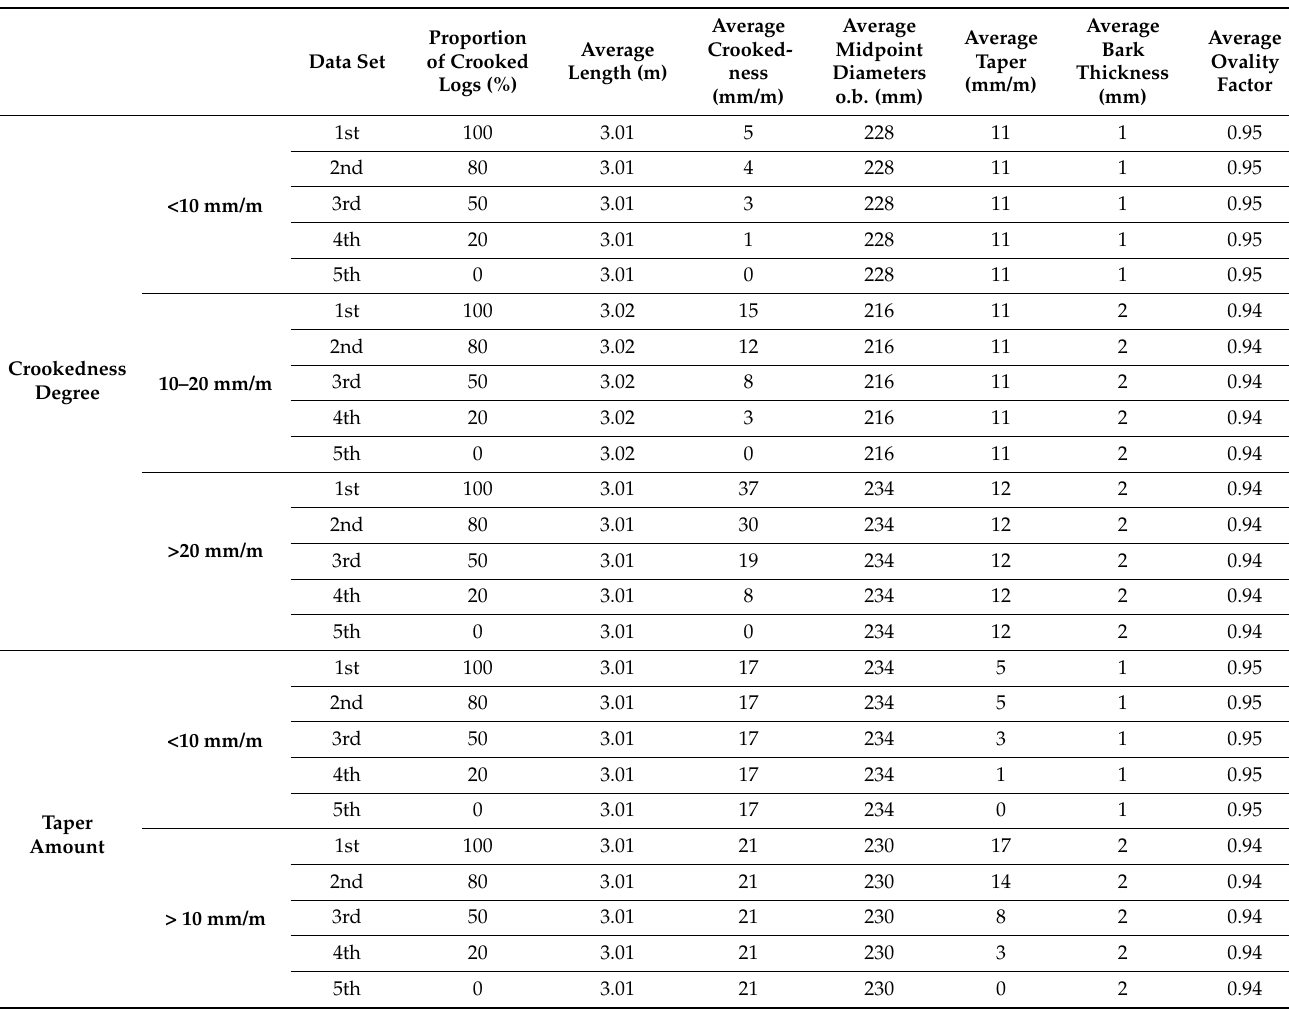
Table 2. Average values of the parameters for each data set to analyze the influence of the proportion of tapered and crooked wood in a stack on the stack